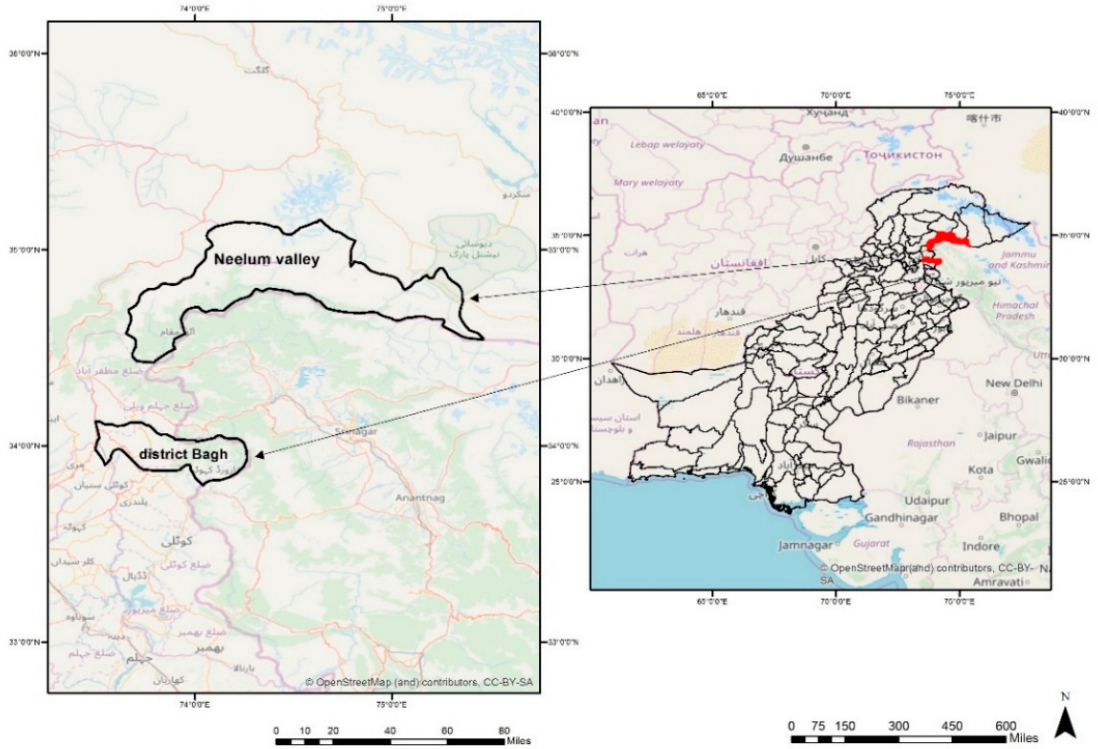
Figure 1. Map displaying the geographical location of the study area: Neelum Valley and Bagh District in Azad Jammu and Kashmir (AJK), Pakistan.